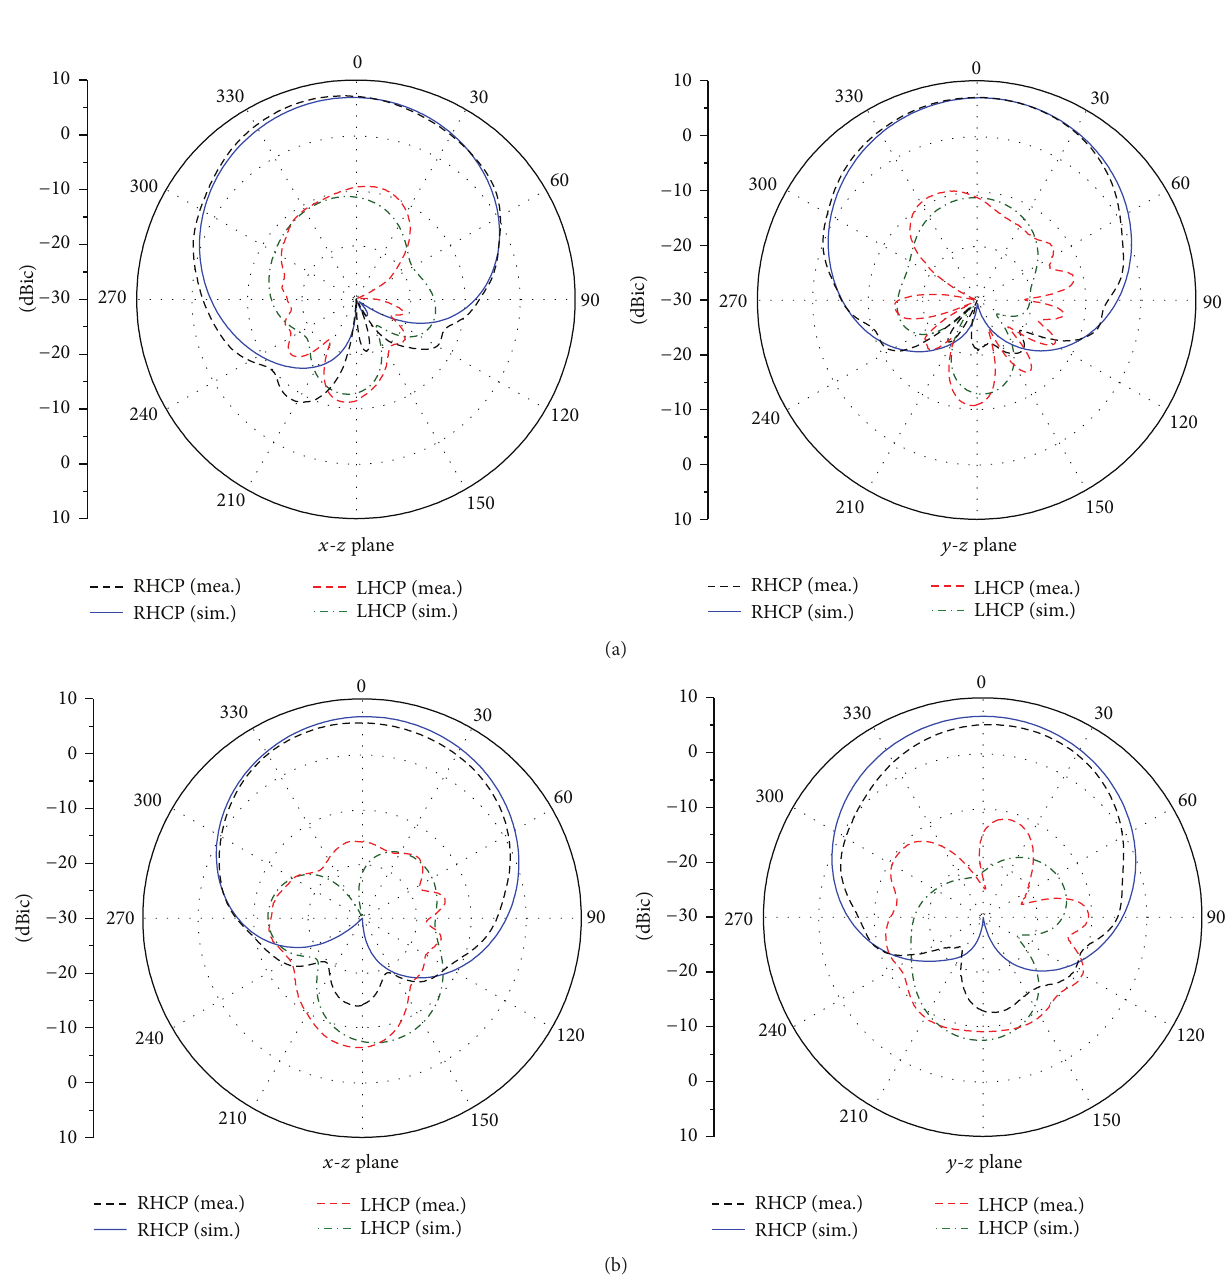
Figure 12: Radiation patterns of the dual-band GPS antenna at (a) GPS L1 and (b) GPS L2